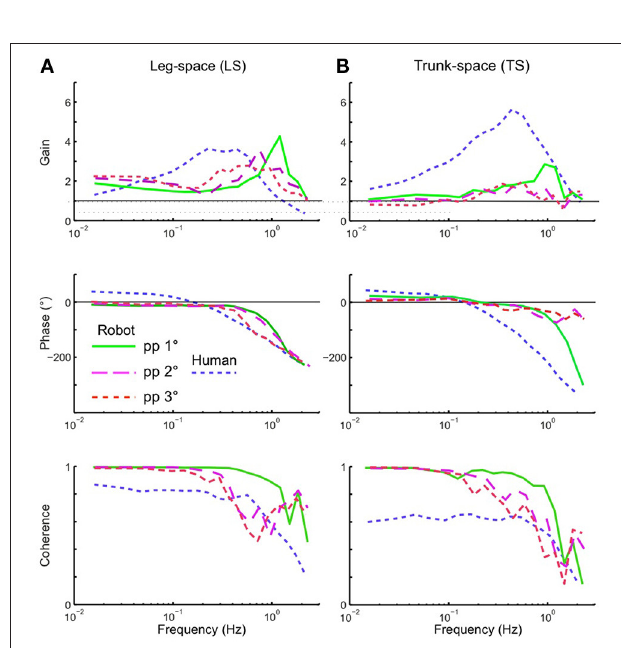
FIGURE 12 | Balancing of stance on tilting support surface of the robot without vestibular function (control is exclusively proprioceptive). Shown are frequency response functions (FRFs) and coherence functions for leg in space (LS; A ) and trunk in space (TS; B ). Superimposed are human data for comparison (mean of 5 vestibular-loss subjects, eyes